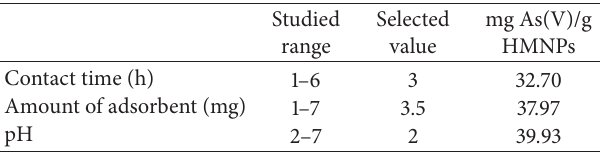
Table 1: Adsorption process: optimization of variables.